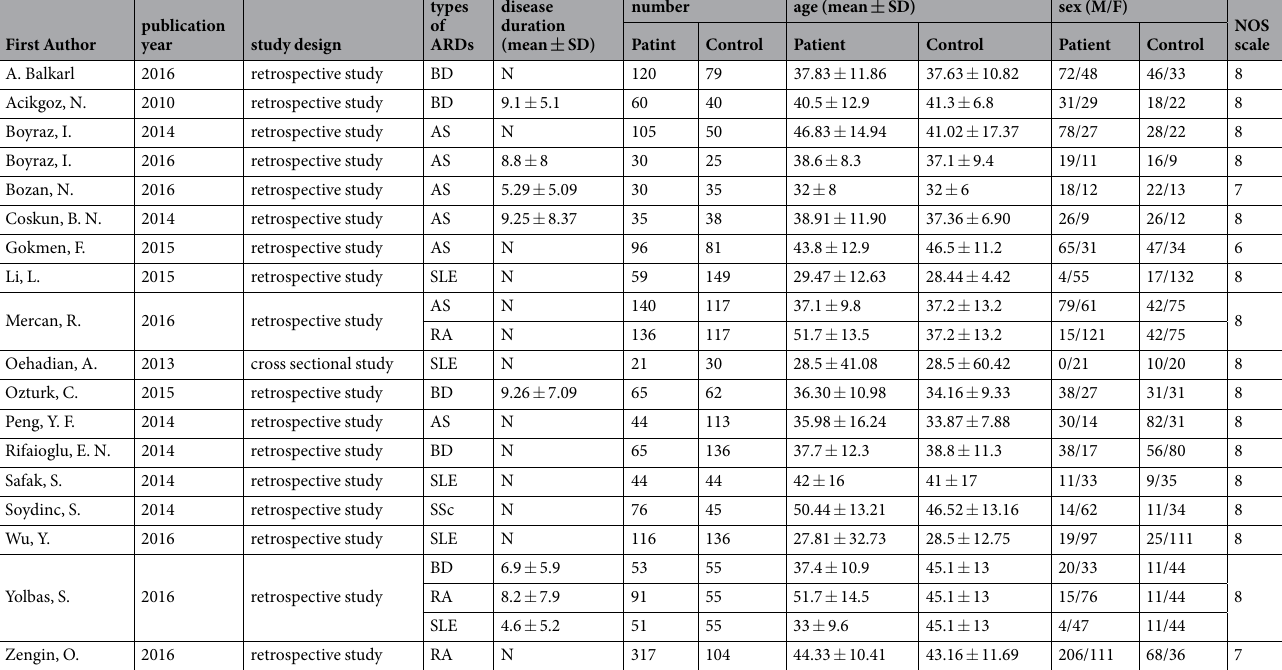
Table 1. General characteristic of the included studies. F: female; M: male; RA: rheumatoid arthritis; SLE: systemic lupus erythematosus; BD: Behçet’s Disease; AS: ankylosing spongdylitis; SD: standard deviation; NOS: Newcastle-Ottawa